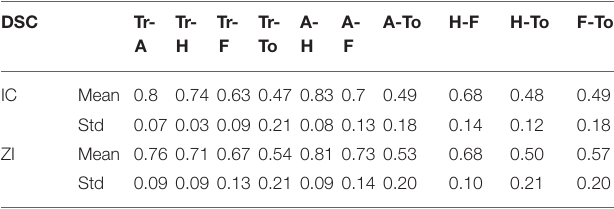
The table shows the mean and standard deviation (std) of the Dice Similarity Coefficient (DSC) of spatial overlap of the fascicles projecting from the trunk (Tr), arm (A), hand (H), face(F),andtongue(To)motorareadisplayedin Figure 2 .Resultsshowthatthefascicles predominantly overlap with a minimum DSC average of 0.47 in the internal capsule (IC) and 0.50 in the zona incerta